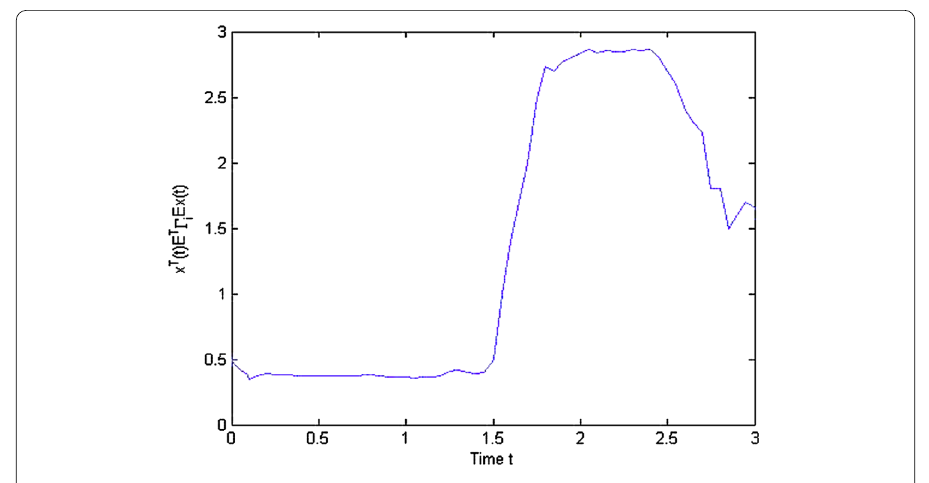
Figure 3 The trajectory of x T ( t ) E T Γ i Ex ( t